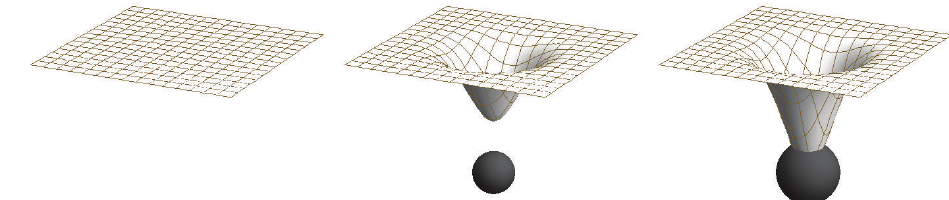
Figure 3: Sketch of brane embeddings in the directions transverse to the D3-brane for di ff erent values of the temperature (cid:2) relative to quark mass (cid:3) . Left: zero temperature, center: small temperature, right: high temperature, here the brane crosses the